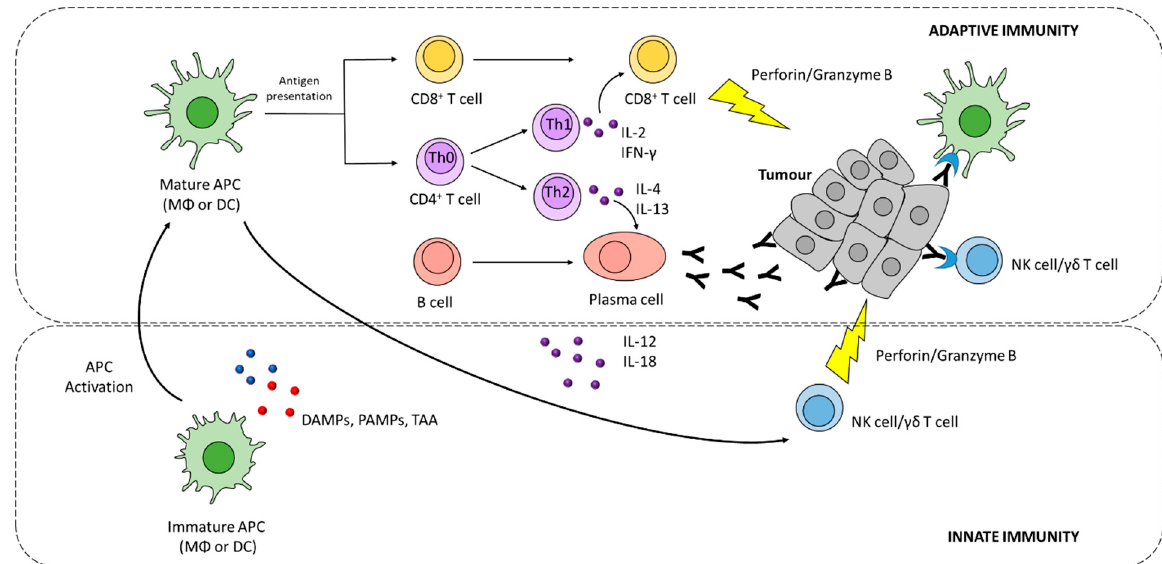
Figure 1. Overview of innate and adaptive anti-tumour immunity. Activated NK cells and γδ T cells can directly recognize and kill tumour cells through the release of perforin and granzyme B. Antigen-presenting cells (APCs), such as macrophages and dendritic cells, represent the main link between innate and adaptive immunity. Resting APCs can be activated by DAMPs and PAMPs, and then migrate to the secondary lymphoid organs where they present antigens and activate lymphocytes (CD8 + and CD4 + T cells, B-cells). CD4 + T cells primarily provide help for B lymphocytes and CD8 + T cells, whereas most CD8 + T cells exhibit cytotoxicity toward tumour cells. On the other hand, B cells are the source of antibodies directed against the tumour, which contribute to tumour recognition and antibody-dependent cell cytotoxicity (ADCC).